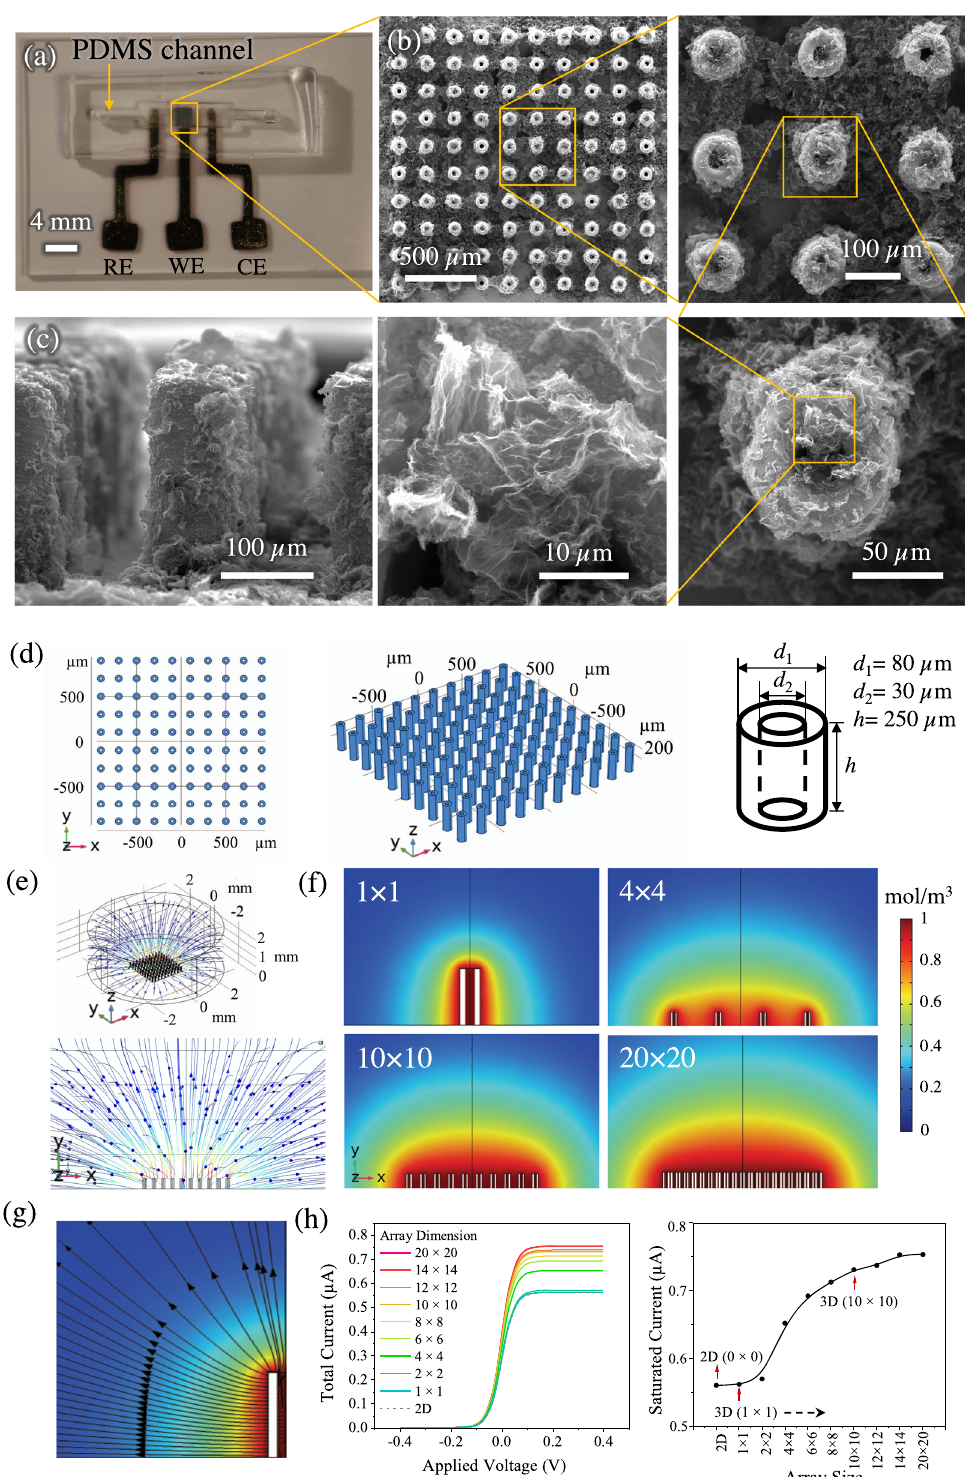
ferricyanide ([Fe(CN) 6 ] 3 − /4 − ) redox mediator (Fig. 3a). The CV curves demonstrate excellent oxidation and reduction peaks of the redox species for both electrode con fi gurations indicating that the electrodes exhibited surface-controlled process. The sensor with 3D Ag/rGO micropillar architecture showed a superior oxidation current (16 µA) compared to the sensor with 2D Ag/ rGO (9 µA) electrode (Fig. 3a). Compared to 2D Ag/rGO elec- trode (0.22 V), the 3D Ag/rGO electrode showed a lower peak-to-